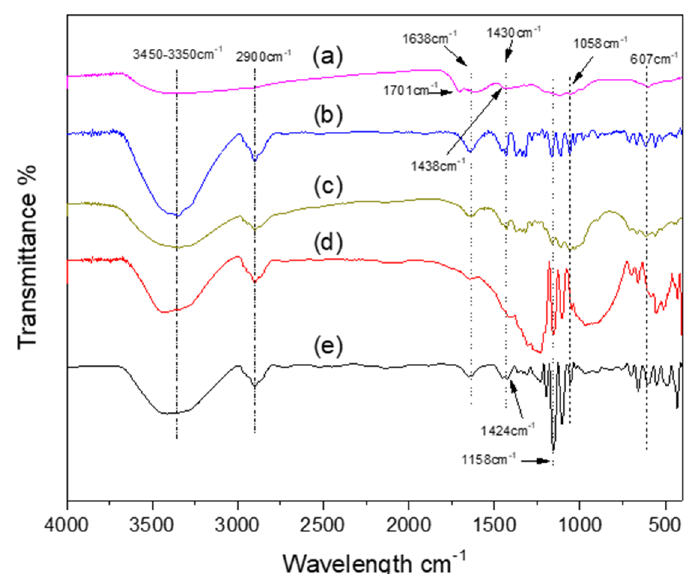
Figure 5. FTIR spectra of (a) CCuNP 10.0, (b) CCuNP 5.0, (c) CCuNP 2.5, (d) HT-C and (e) UT-C.